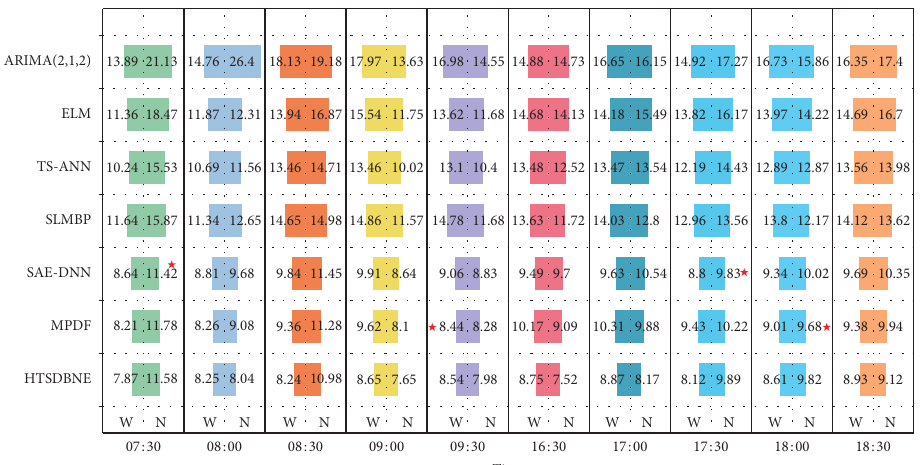
Figure 13: Comparison between HTSDBNE and other models (MSE) (station 7 of line 28). The column W shows the results of working day, and column N shows the results of nonworking day.